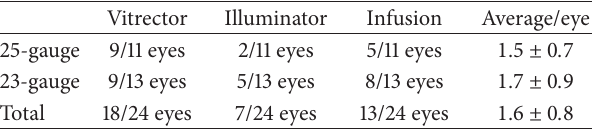
Table 2: The number and site of leaking